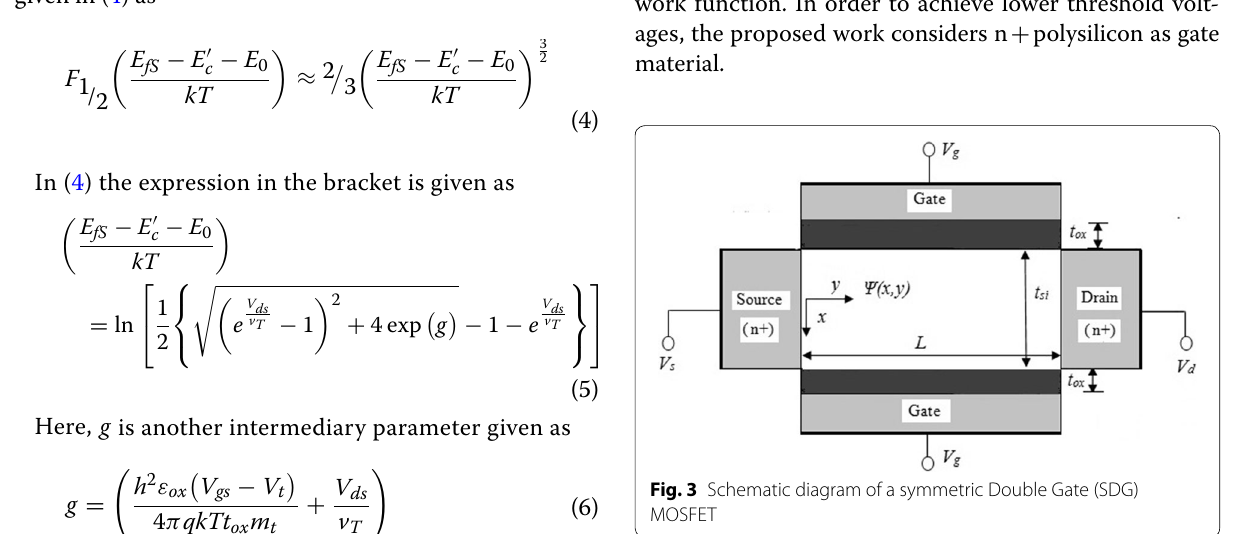
where the parameter Fermi–Dirac integral is then approximated as in [13] and given in (4) as